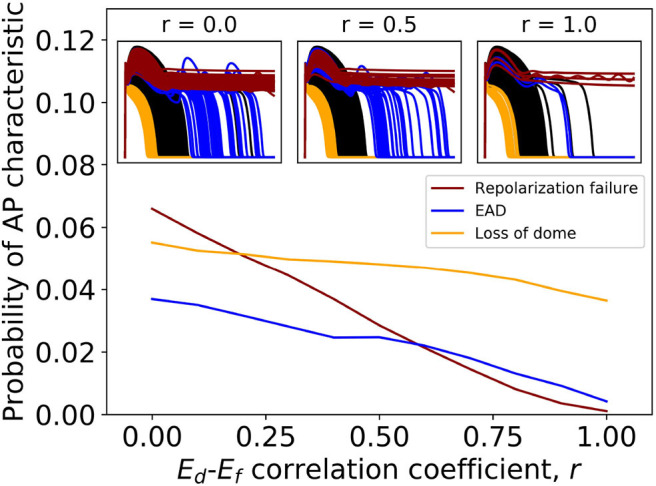
Effect of introducing correlation between half-activation voltage Ed and half-inactivation voltage Ef on ICaL variability results. Probabilities of repolarization failure, early-after depolarizations (EADs) and loss of dome morphology all decreased with increasing correlation.